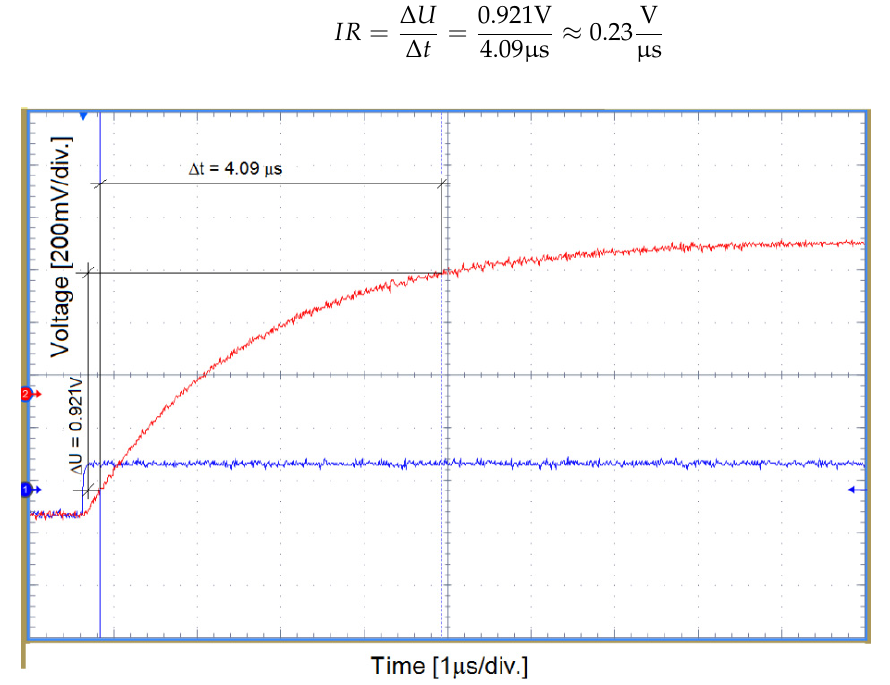
Figure 8. Determination of impulse response IR of the receiver circuit.